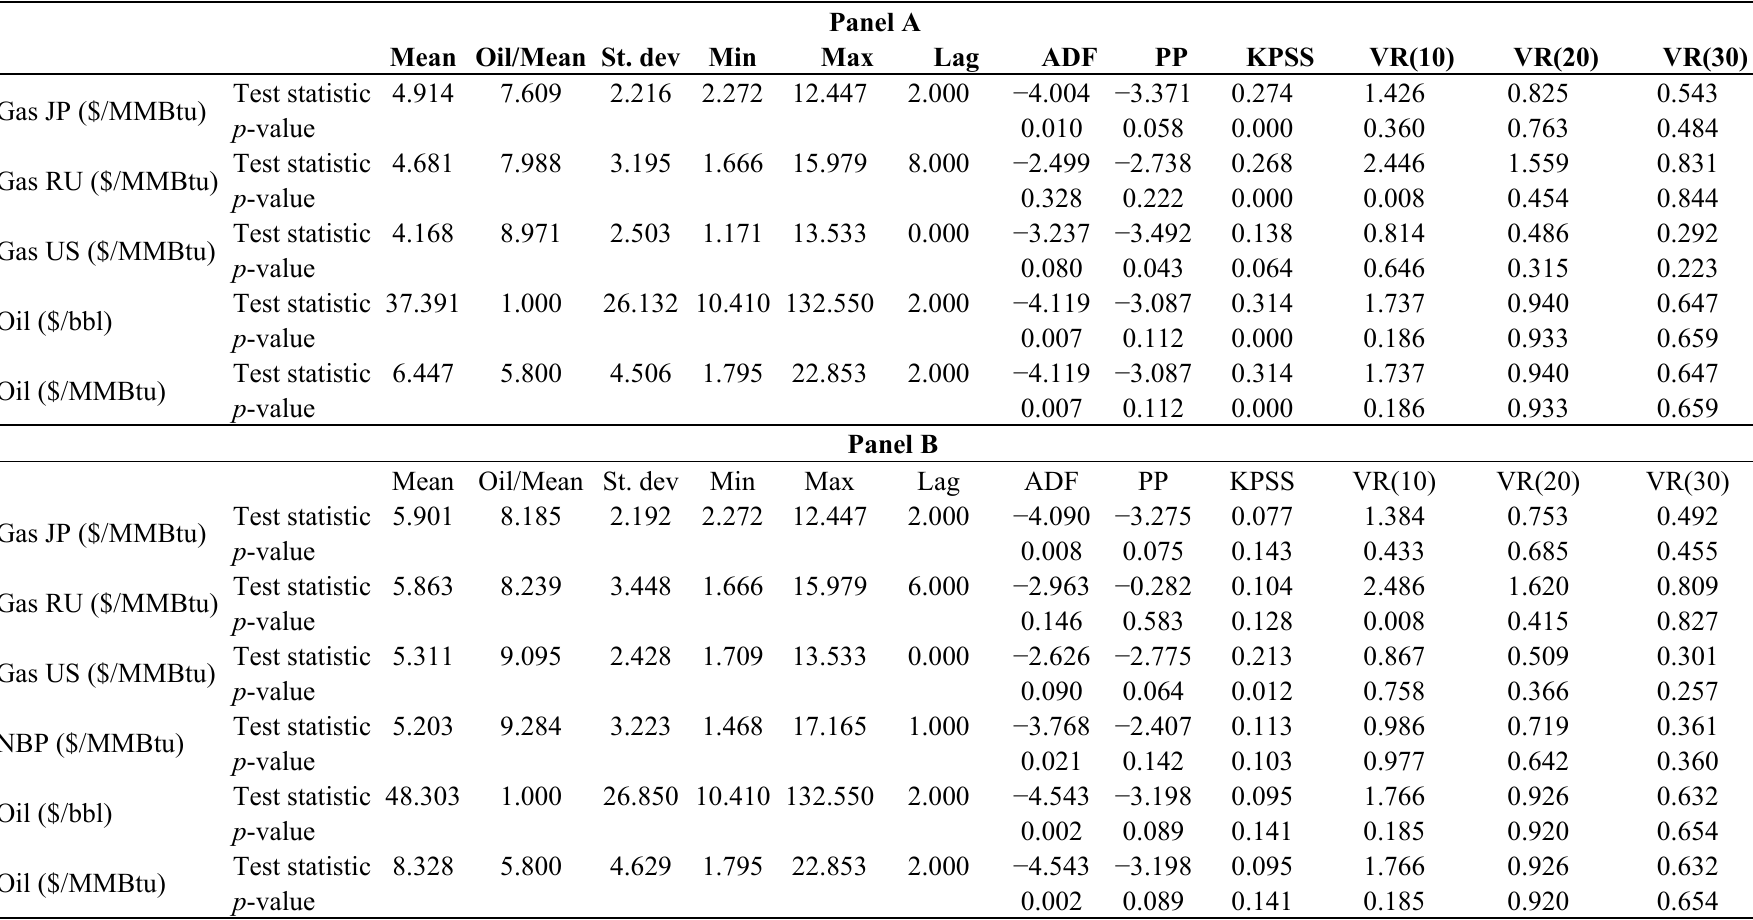
Table 1. Descriptive statistics of Japanese LNG, Russian, US and UK natural gas and oil prices. Panel